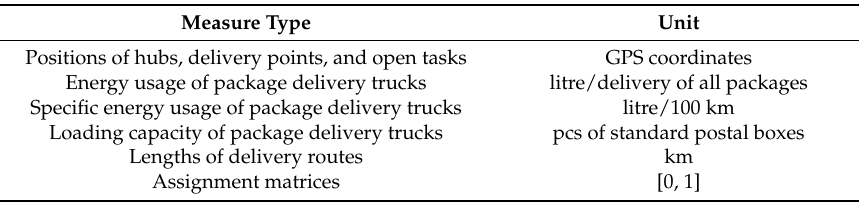
Table 1. Units of measures used in the model.